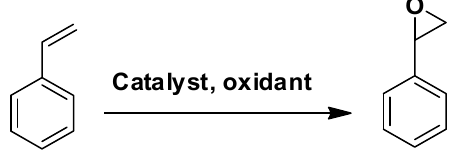
Scheme 3. General scheme of styrene epoxidation.